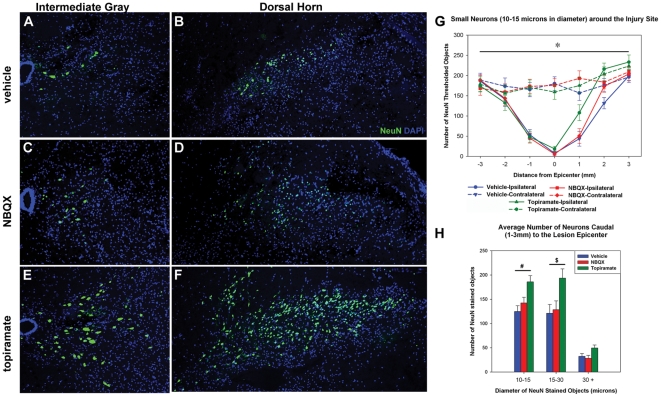
Topiramate treatment significantly increased NeuN+ neuron sparing 48-hrs after severe spinal cord injury.A–F) Representative examples of NeuN labeling ipsilateral to the side of injury 1 mm-caudal to lesion epicenter. Pictures are from around the central canal (A,C,E) and dorsal horn (B,D,F). Notice the increased number of neurons in the topiramate treated group. G) The number of small sized neurons remaining 48 hrs after injury by group. Graphs were similar for medium and large sized neurons. H) More small, medium, and large neurons were spared caudal to the lesion epicenter following topiramate treatment (ANOVA for large diameter neurons, p = 0.051). #,&p<0.05 for topiramate vs. vehicle; #p = 0.052 and &0.057 for topiramate vs. NBQX. *There were significant differences among groups as a function of distance from the lesion epicenter; therefore only caudal neuron numbers were considered in (H) (p<0.05 for distance x group interaction two-way ANOVA).